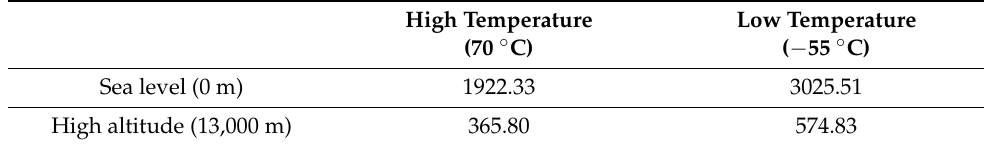
Table 6. Ventilation resistance under different operating conditions (unit: kg · s 2 /m 6 ).